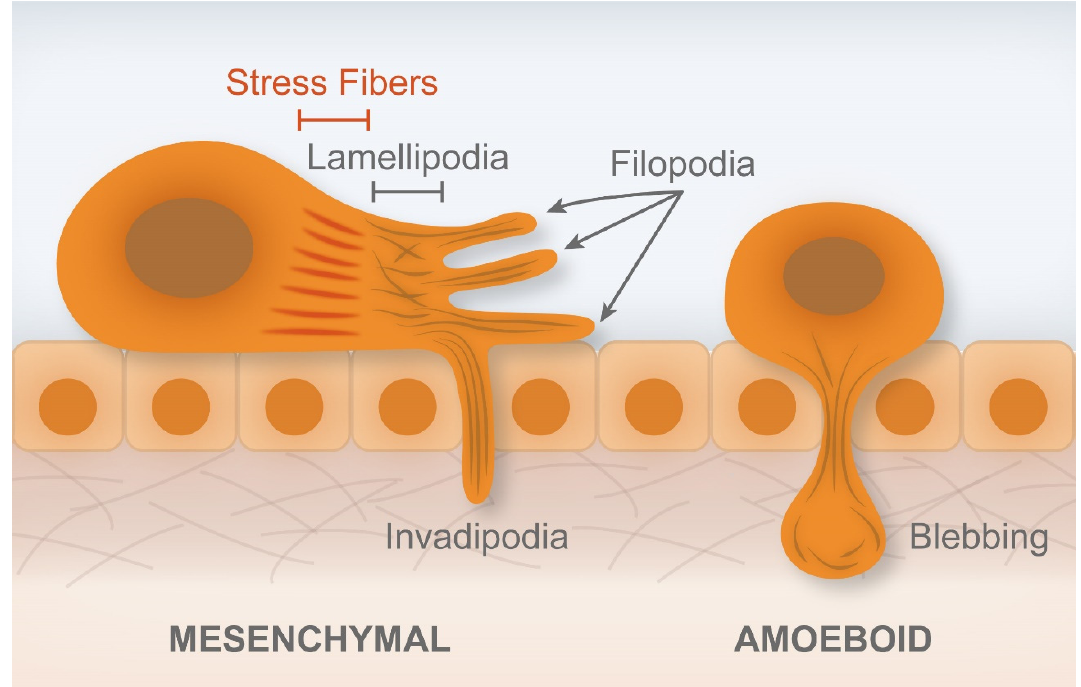
Figure 3. Cell migration though the epithelium and basal membrane (invadipodia) and through the reorganization of the cortex (blebbing). The cells are pushed in a certain direction due to the lamel- lopodia and filopodia forces produced at the leading edge. After receiving microenvironmental cues (such as growth factors, cell-cell contacts and extracellular matrix signals), invadopodia invade the neighboring tissues. Re-organization of cell cortex can induce blebbing, which facilitates amoeboid- like migration. Adapted from Biber et al.